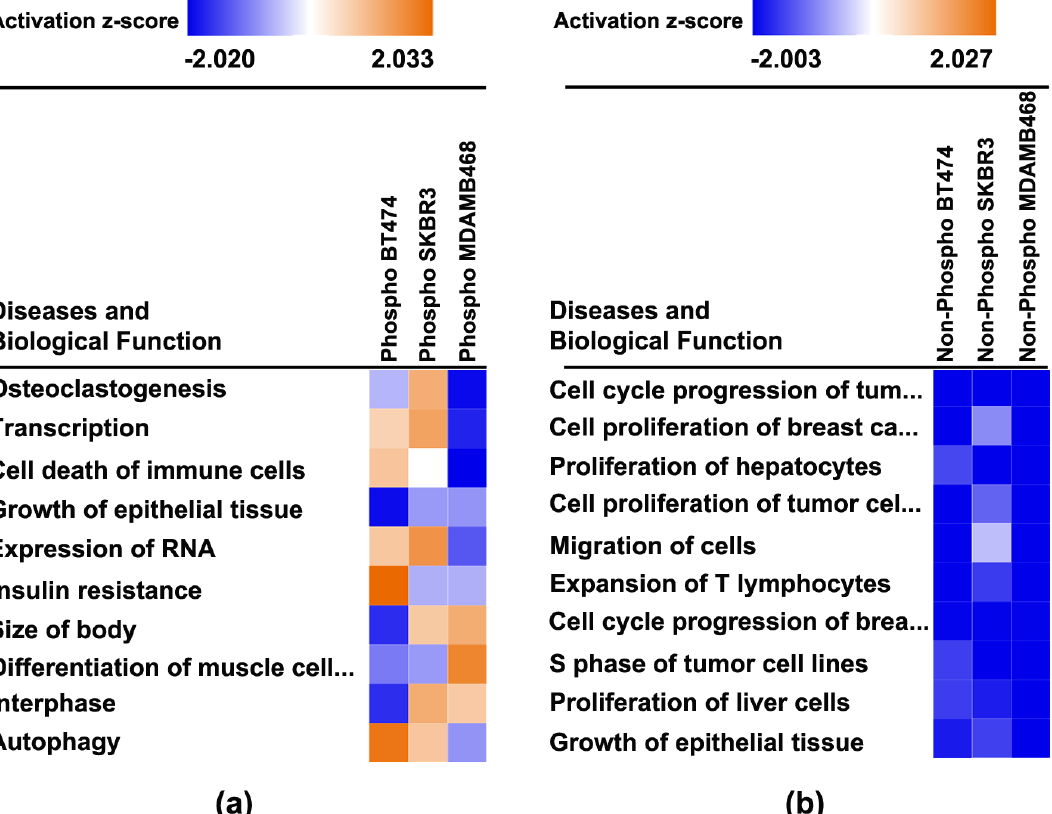
Figure 8. Regulation of diseases and cell functions by 4-oxo-DHA was observed across three molecular subtypes of breast cancer cell lines. The Core Analysis algorithm in IPA also identifies diseases and functions within cells that are consistent with the protein expression data. Those data are shown in heat maps based on the expression of ( a ) phosphorylated and ( b ) non-phosphorylated proteins. Shades of red indicate that the biological function was activated by treatment with 4-oxo-DHA; greater color intensity indicates stronger evidence of activation. Shades of blue indicate that the biological function was inhibited by treatment with 4-oxo-DHA; greater color intensity indicates stronger evidence of inhibition. The absence of coloration indicates that the evidence was not strong enough to permit a prediction of biological function status.